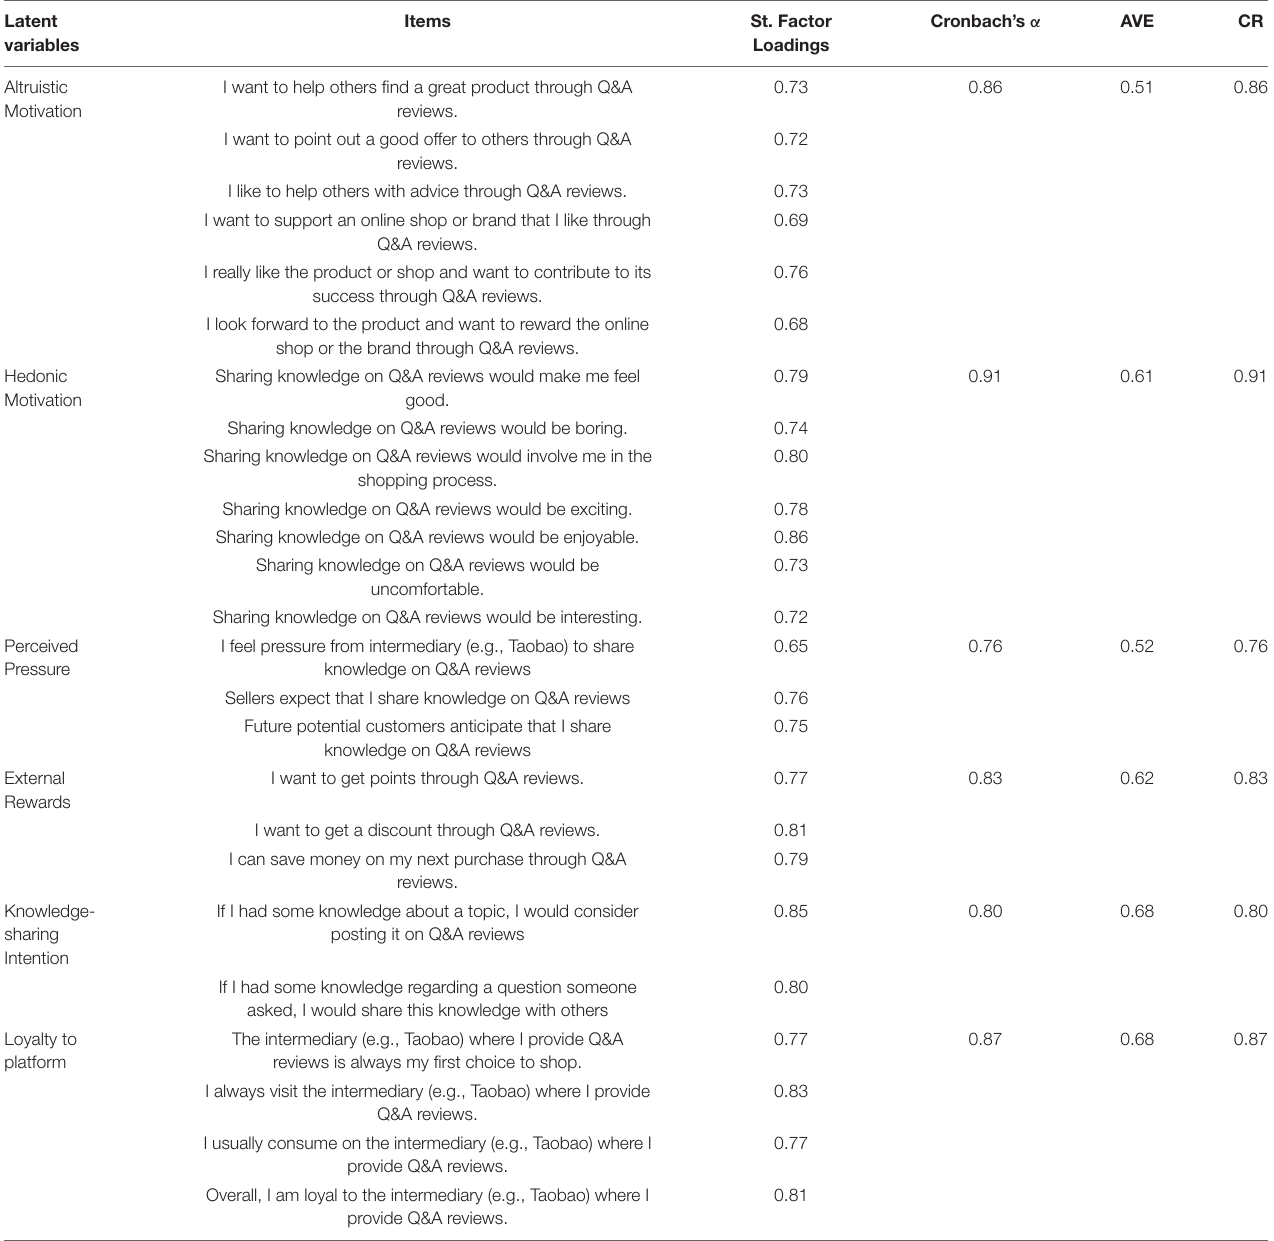
TABLE 1 | Items, factors loadings, and reliability estimates. Latent